Question: Looking at the figure, what chart type is it?
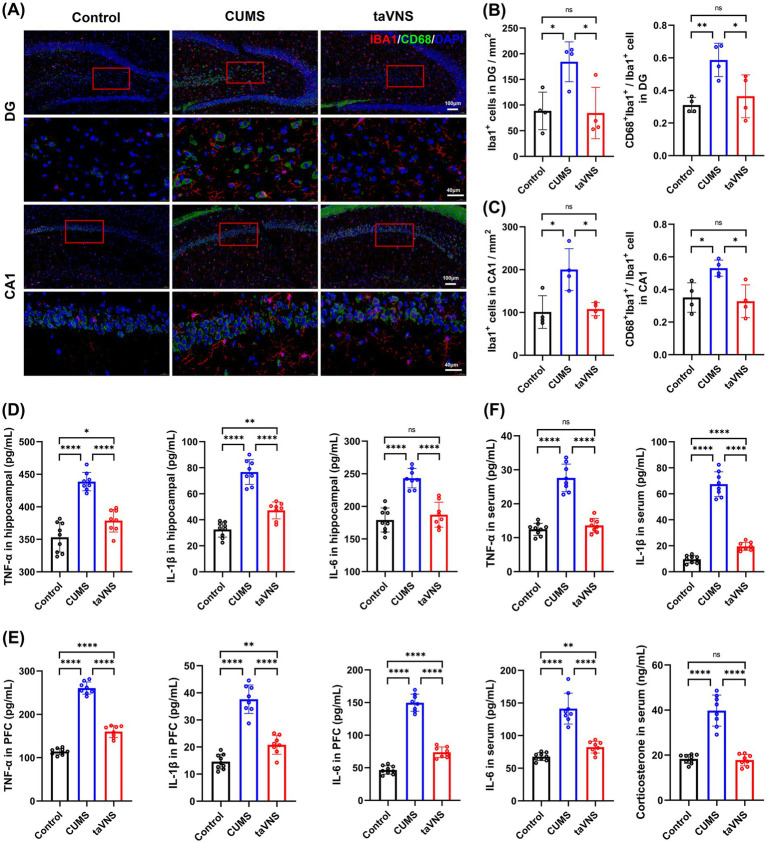
Answer: bar